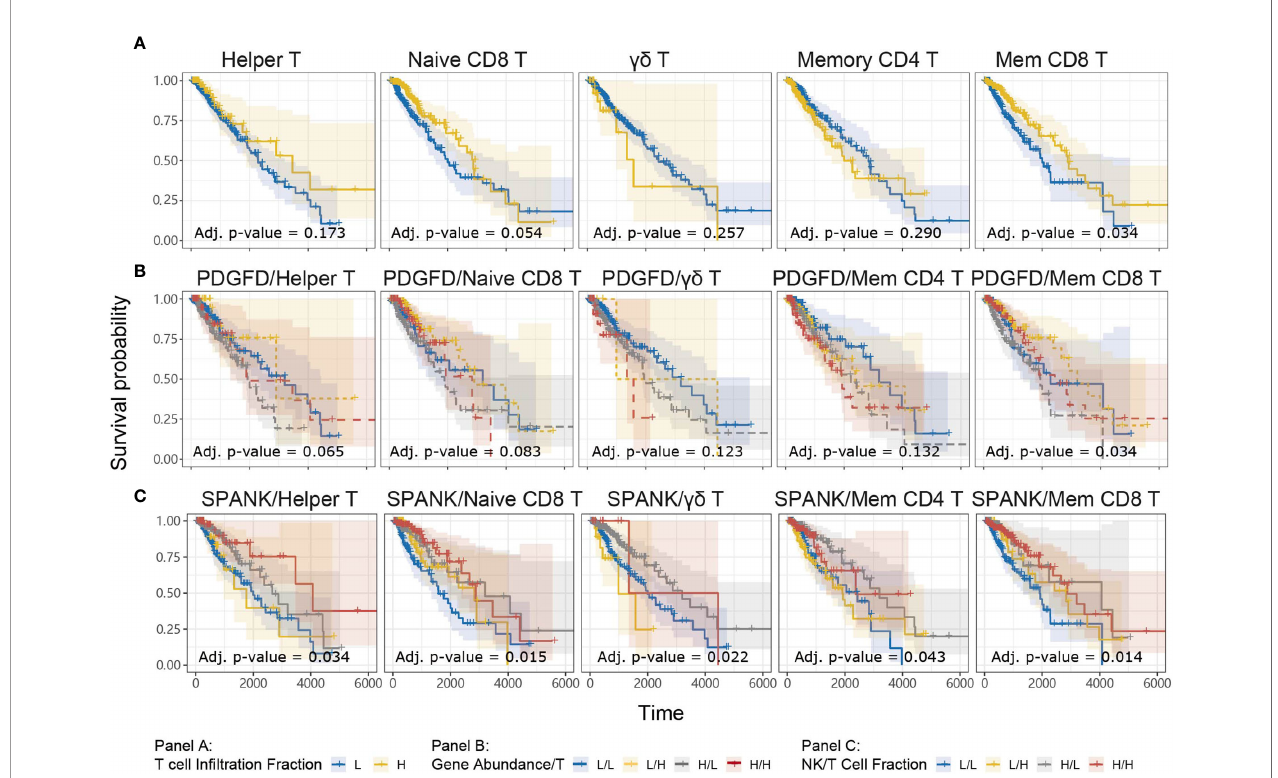
FIGURE 5 | Tumor abundance of memory CD8 + and Helper T cells in fl uences TCGA LGG prognosis KM curves displaying the survival of LGG patients split by median fraction into low (L) and high (H) tumor expression of (A) each T cell phenotype alone, (B) PDGFD and each T cell phenotype, respectively, or (C) each NK cell and each T cell phenotype, respectively. KM curves display the survival of LGG patients plotted in all combinations for each